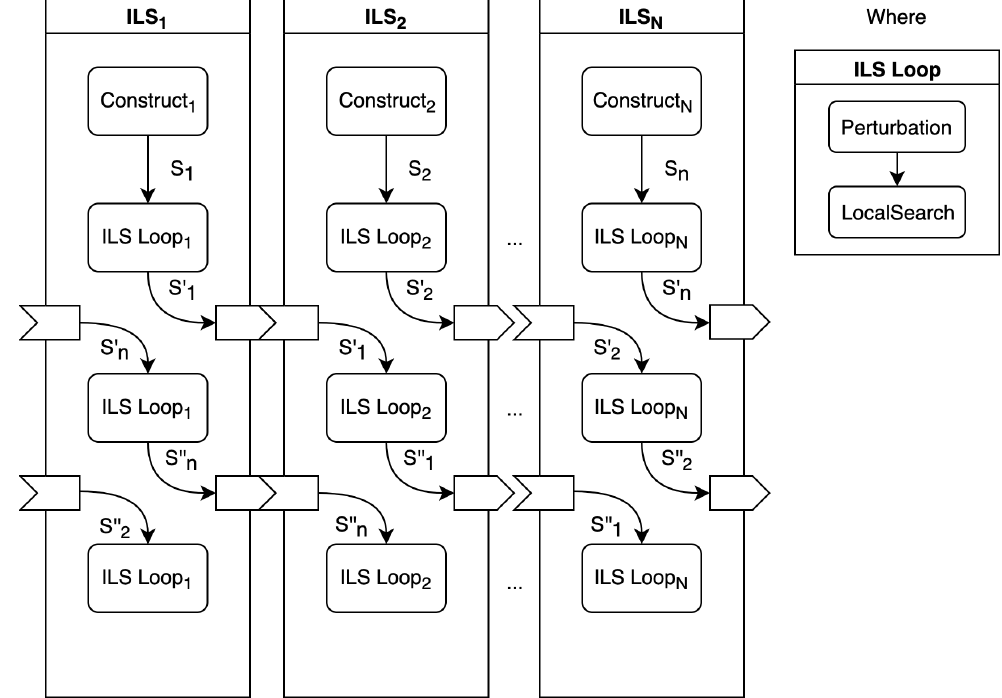
Figure 6. Parallel cooperation scheme for the ILS based on solution